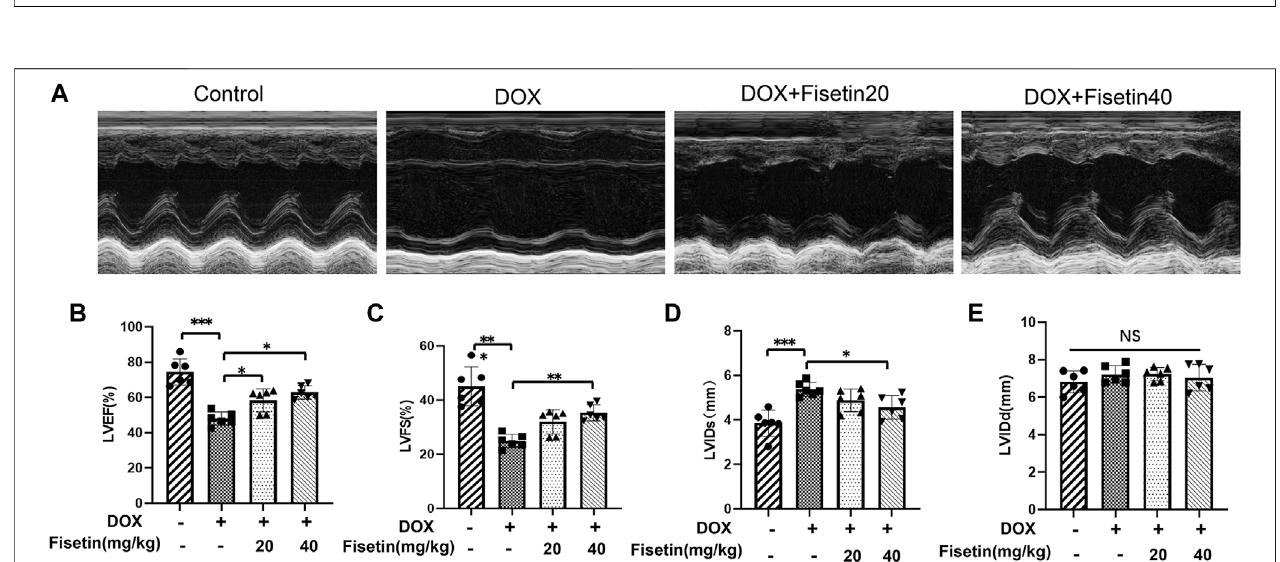
FIGURE 2 | Fisetin attenuates DOX-induced myocardial dysfunction in rats. (A) . Representative echocardiogram images of each group. Results of (B) LVEF, (C) LVFS, (D) LVIDs,and (E) LVIDdinfourgroupexperimentalrats( n =6pergroup).Theresultsshowedtheeffectof fi setinonattenuatingDOX-inducedLVdysfunction.The valuesarepresentedasmean±SD.* p < 0.05;** p < 0.01;*** p < 0.001;NS,nosigni fi cance;LV,leftventricular;LVEF,LVejectionfraction;LVFS,LVfractionalshortening; LVIDs, LV end-systolic internal dimension; LVIDd, LV end-diastolic internal dimension.